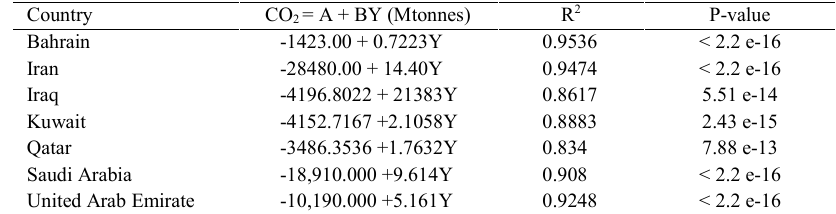
Table 3: The projected data of CO 2 emission from 2011 to 2050 Country